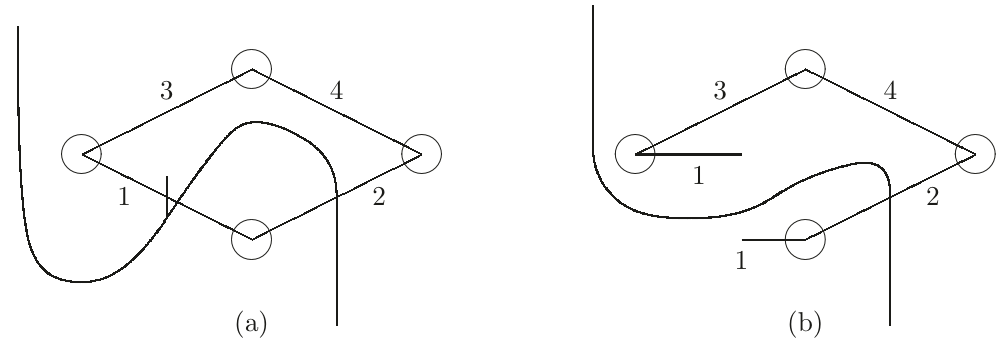
Figure 1 . Figure (a) shows a cut reduced diagram in which a propagator P propagator in the original diagram and the cut passes through the propagator P 1 in the reverse direction and the propagator P 2 in the correct direction. In our notation this will be labelled as A (1) Figure (b) shows a more conventional depiction of the same diagram in which the cut propagator P 1 is depicted as one outgoing and one incoming particle carrying identical quantum